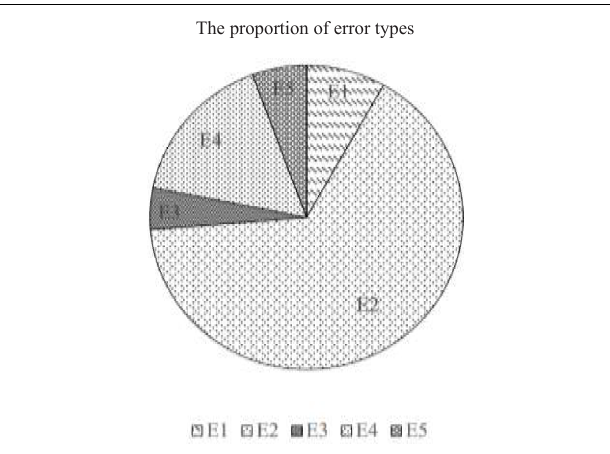
FIGURE 1 | The proportion of error types. E1, mismatch of connectives; E2, misuse of connectives; E3, underuse of connectives; E4, overuse of connectives; E5, misplacement of